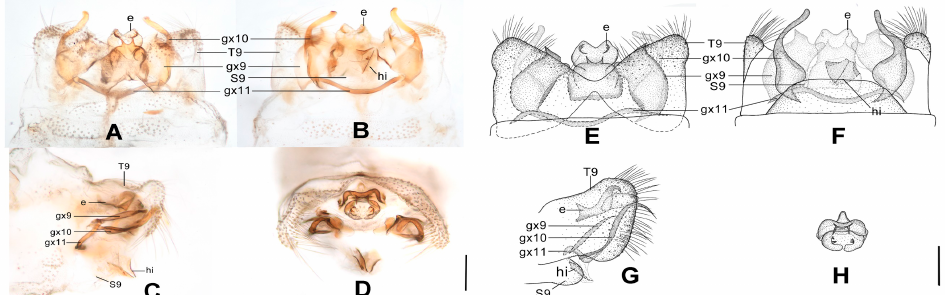
Figure 10. Dilar phraenus sp. nov. ( A – D ) male holotype, genitalia, photographs: ( A ) dorsal view; ( B ) ventral view; ( C ) lateral view; ( D ) caudal view. ( E – H ) male holotype, genitalia, line drawings: ( E ) dorsal view; ( F ) ventral view; ( G ) lateral view; ( H ) ectoproct, caudal view. dp: dorsoprocessus; e: ectoproct; gx9: gonocoxite 9; gx10: gonocoxite 10; gx11: fused gonocoxites 11; S9: sternum 9; T9: tergum 9. Scale bars: 0.2